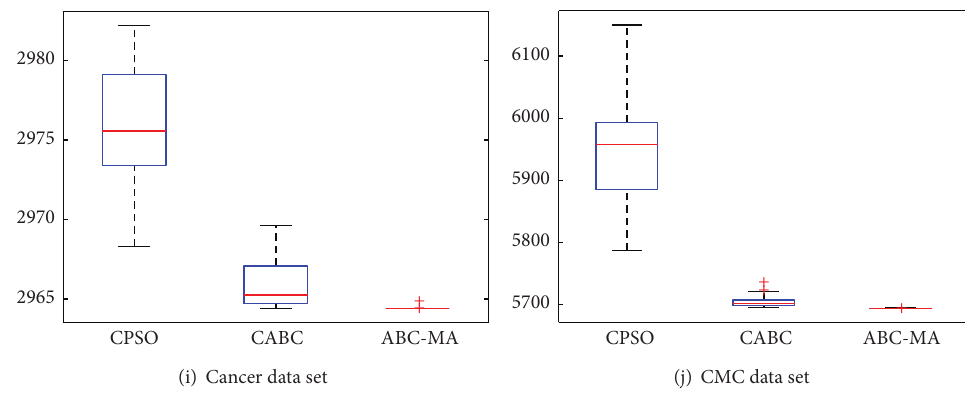
Figure 22: The boxplots of distribution of the objective values obtained by CPSO, CABC, and ABC-MA over 20 independent